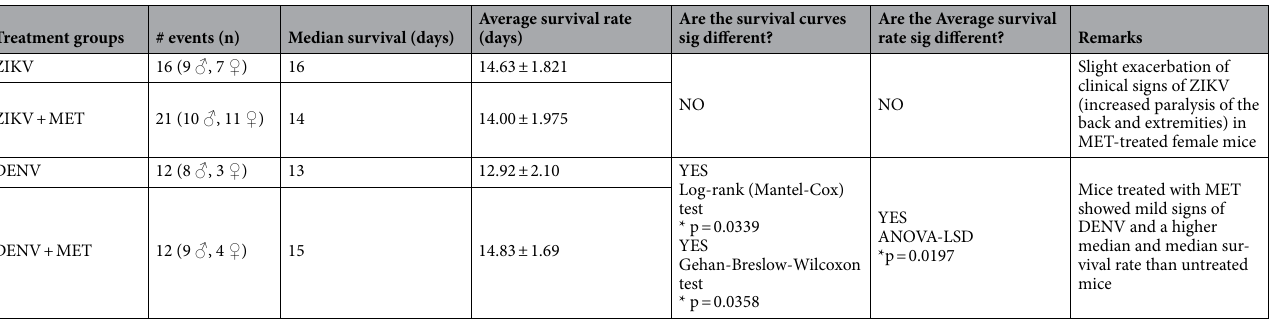
Table 2. Effect of MET treatment on ZIKV or DENV infected AG129